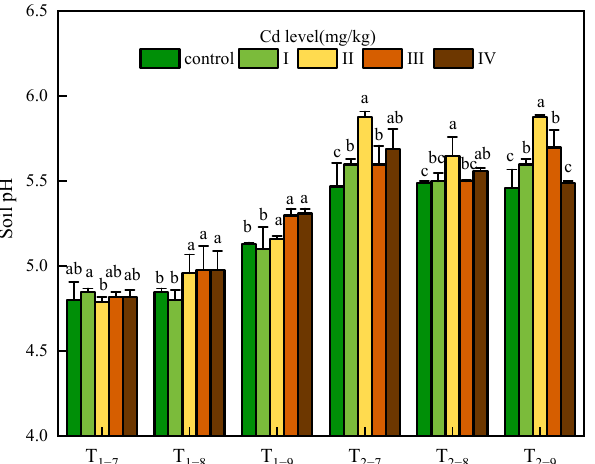
Figure 1. Soil pH under Cd treatment control, I, II, III and IV. T i–j means soil sampled at a certain point (i = 1,2, represents the year after transplanting; j = 7,8,9, represents the month for sampling). Error bars indicate standard deviation calculated for three replicates. Significant effects of each treatment on values for soil pH are denoted by different lowercase letters (one-way analysis of variance (ANOVA), p < 0.05).